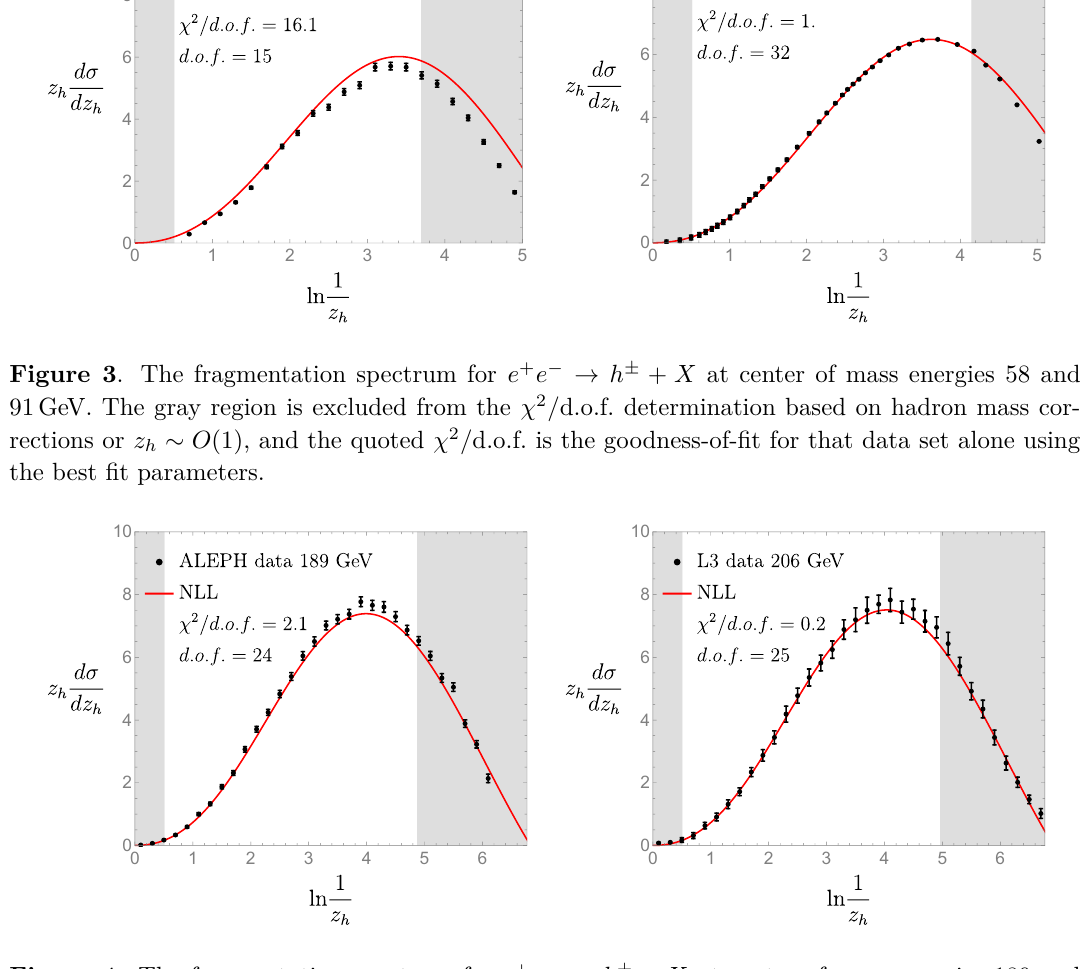
Figure 4 . The fragmentation spectrum for e + e − → h ± + X at center of mass energies 189 and 206 GeV. The gray region is excluded from the χ 2 / d.o.f. determination based on hadron mass corrections or z (1) , and the quoted χ 2 / d.o.f. is the goodness-of-fit for that data set h ∼ O